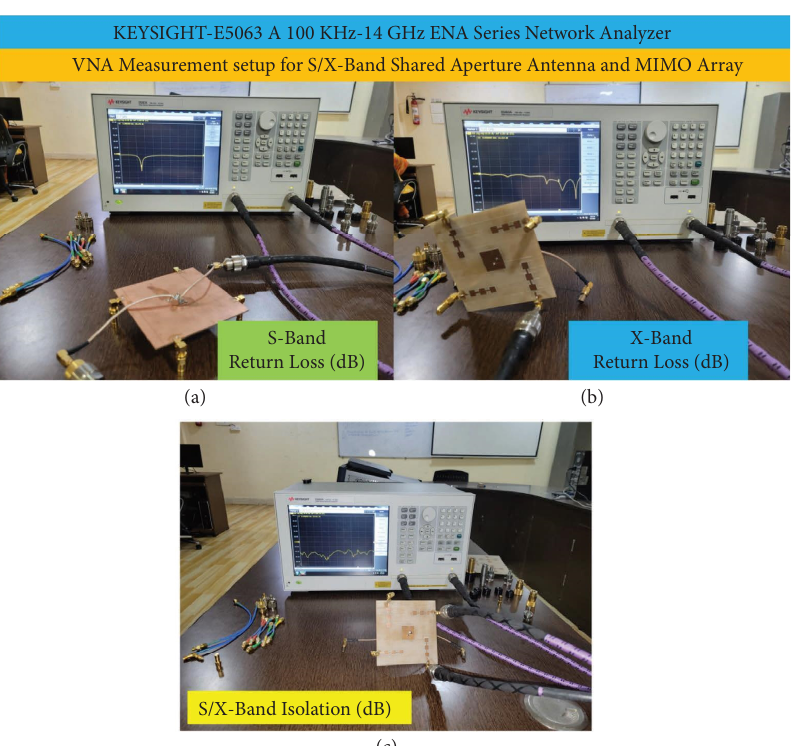
Figure 11: (a) Experimental setup for testing the S-band element. (b) Experimental setup for testing the X-band element. (c) Testing the S/X- band